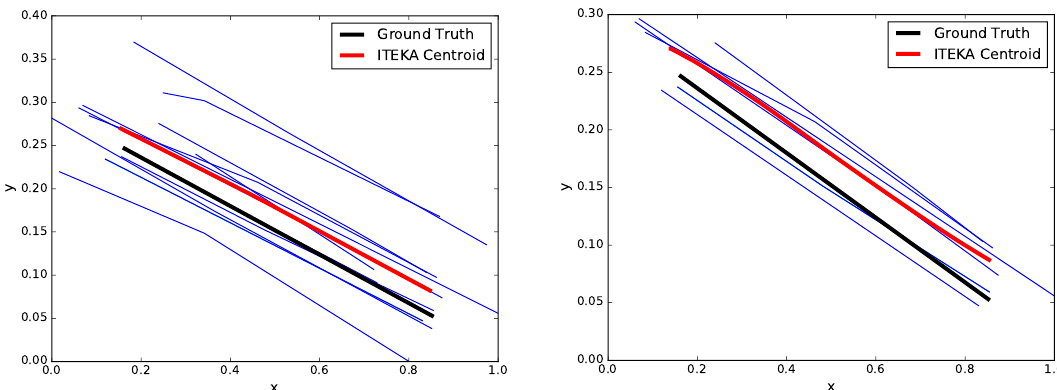
Figure 5. iTEKA centroid estimate (in red) before pruning ( left ) and after pruning ( right ). The blue lines represent trained data, i.e. measured GPS trajectories corresponding to a street segment. The x,y coordinates are latitude and longitude converted in UTM coordinates then normalized in [ 0;1 ]